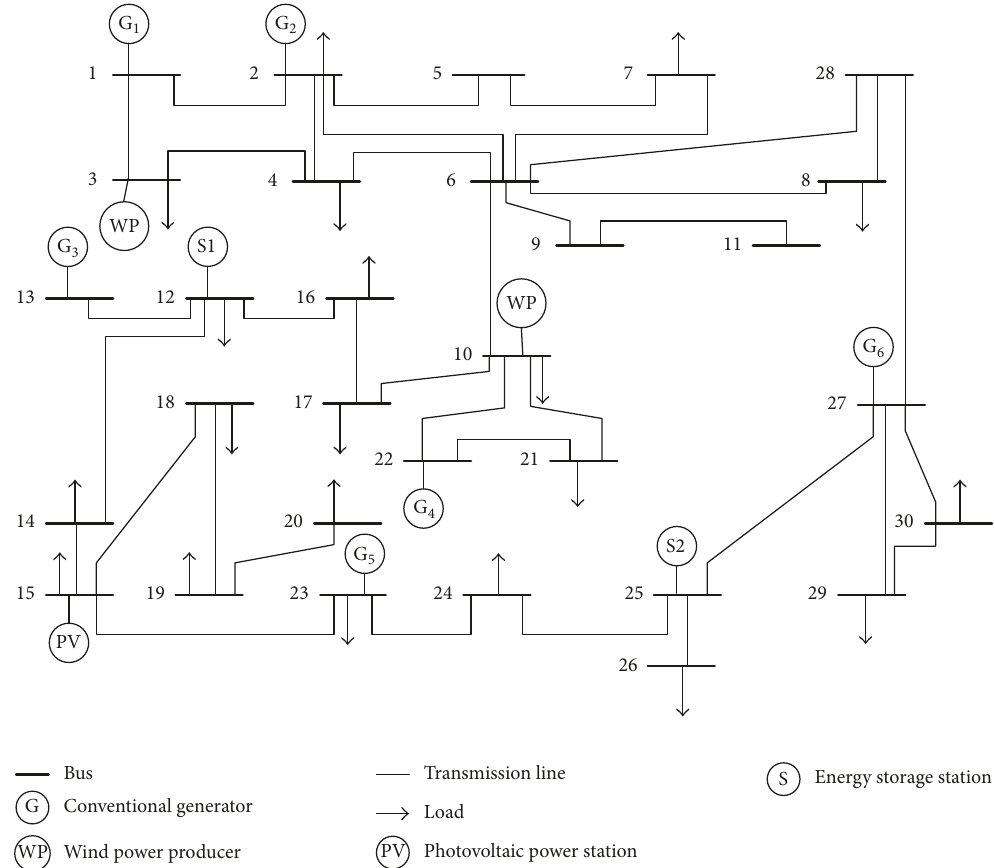
Figure 3: Topology distribution of 30 nodes in PJM system.